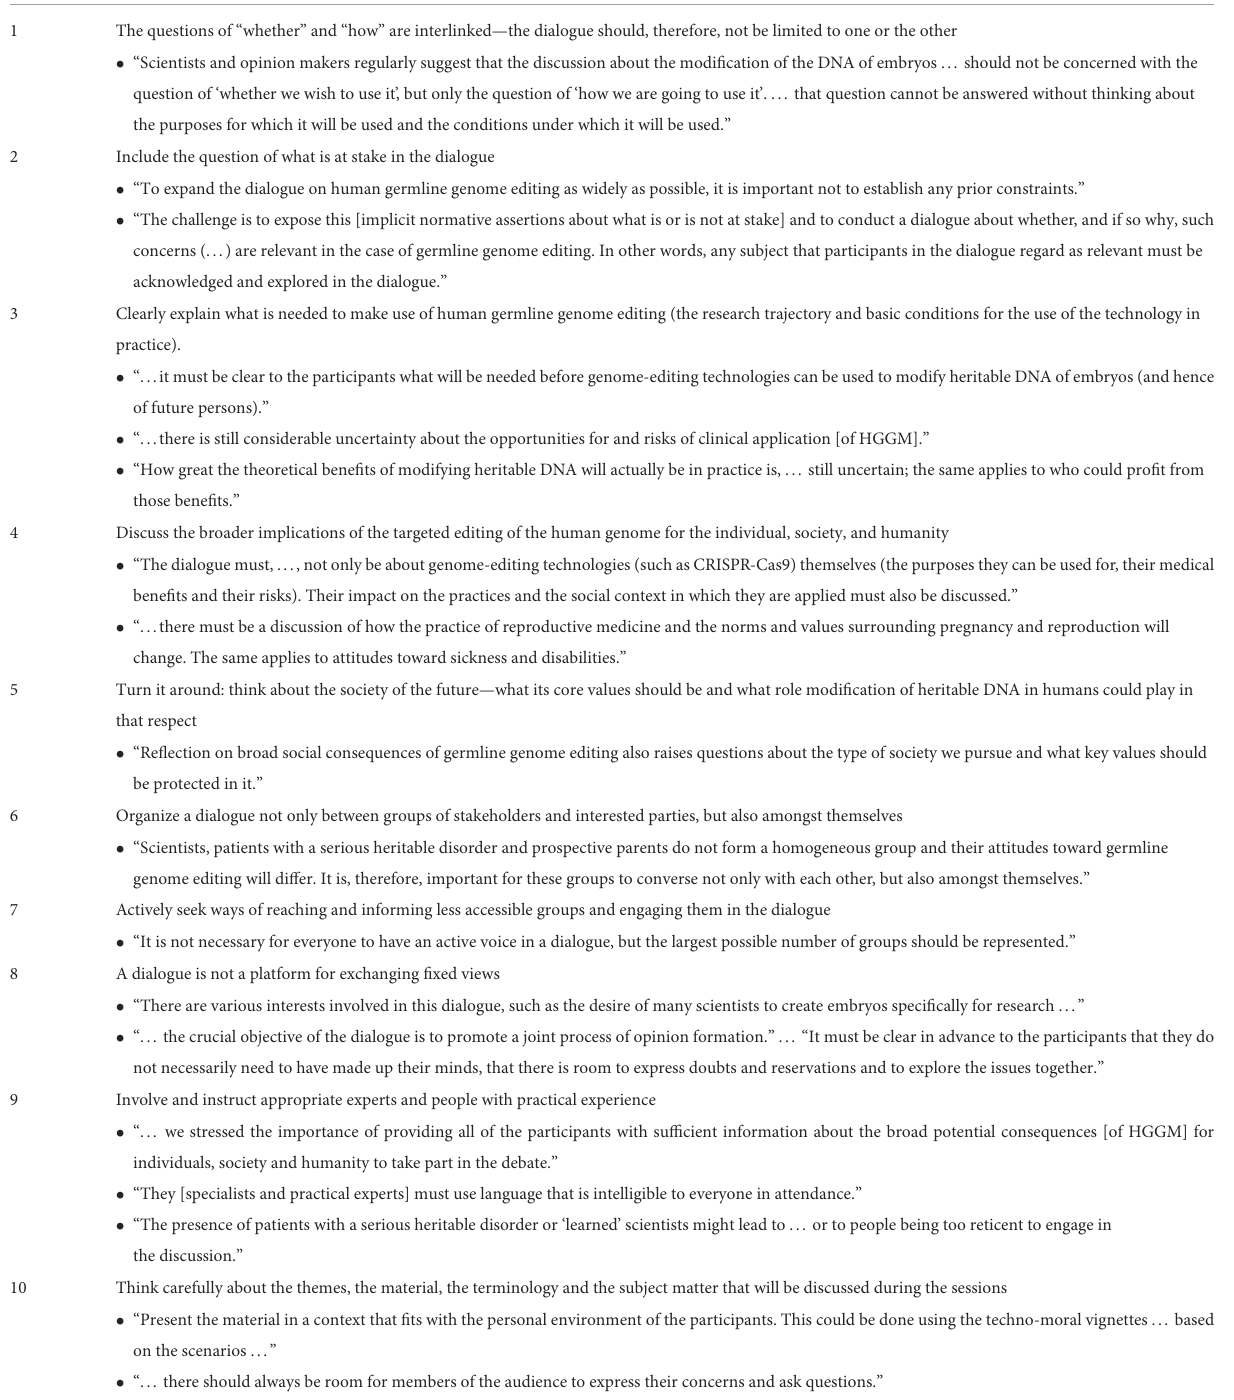
TABLE 1 Lessons for a public